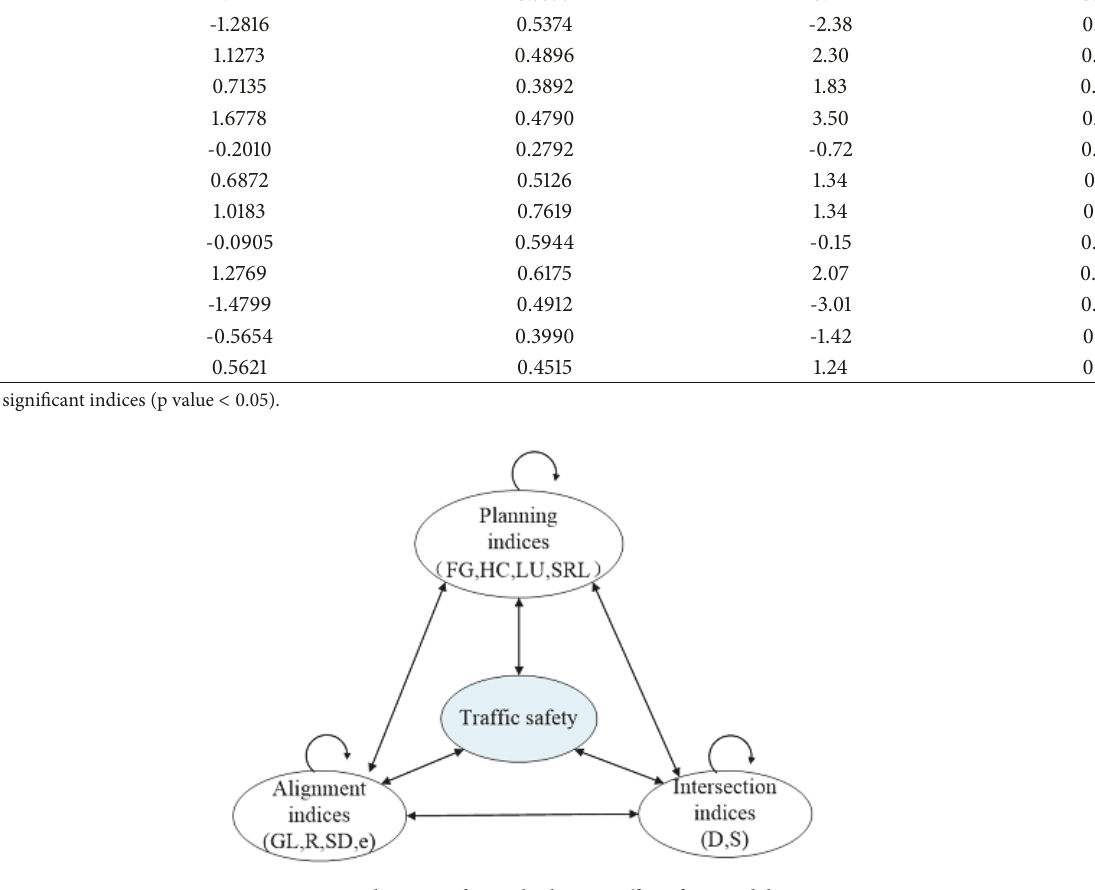
Figure 4: Elements of ANP highway traffic safety model.